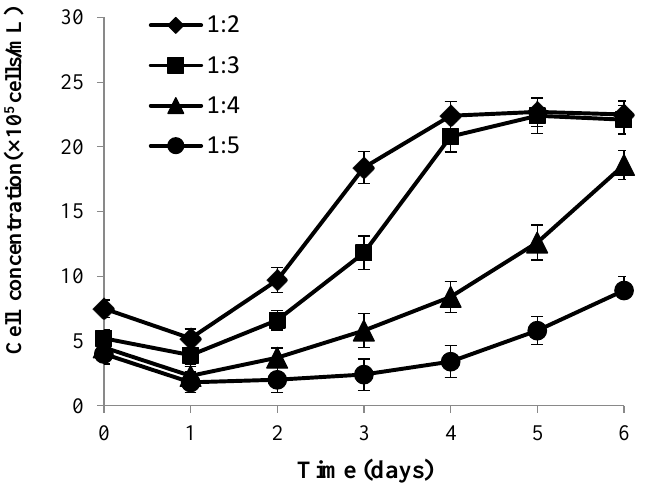
Figure 6. Growth curve of CPB cells at different expansion ratios. Bars show the mean ± SD, n = 3.